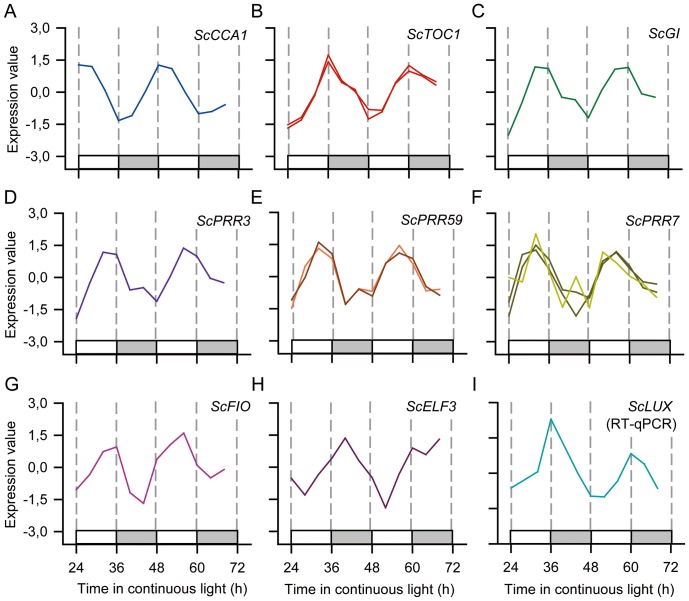
Time courses of probes associated with the central oscillator.Z-score normalized time courses of rhythmic probes for sense sugarcane transcripts associated with the central oscillator. (A–H) Expression levels were measured using oligoarrays. Different probes for the same sugarcane genes are represented separately. Lighter lines indicate probes for antisense transcripts expression of the gene. (I) Expression levels were measured using RT-qPCR, using an arrhythmic GAPDH as reference. (A) CIRCADIAN ASSOCIATED1 (ScCCA1), (B) TIME OF CHLOROPHYLL A/B BINDING PROTEIN EXPRESSION (ScTOC1), (C) GIGANTEA (ScGI), (D) PSEUDO-RESPONSE REGULATOR3 (ScPRR3), (E) ScPRR59, (F) ScPRR7, (G) FIONA (ScFIO), (H) EARLY-FLOWERING3 (ScELF3), and (I) LUX ARRHYTHMO (ScLUX). White boxes represent periods of subjective day and light grey boxes represent periods of subjective night.